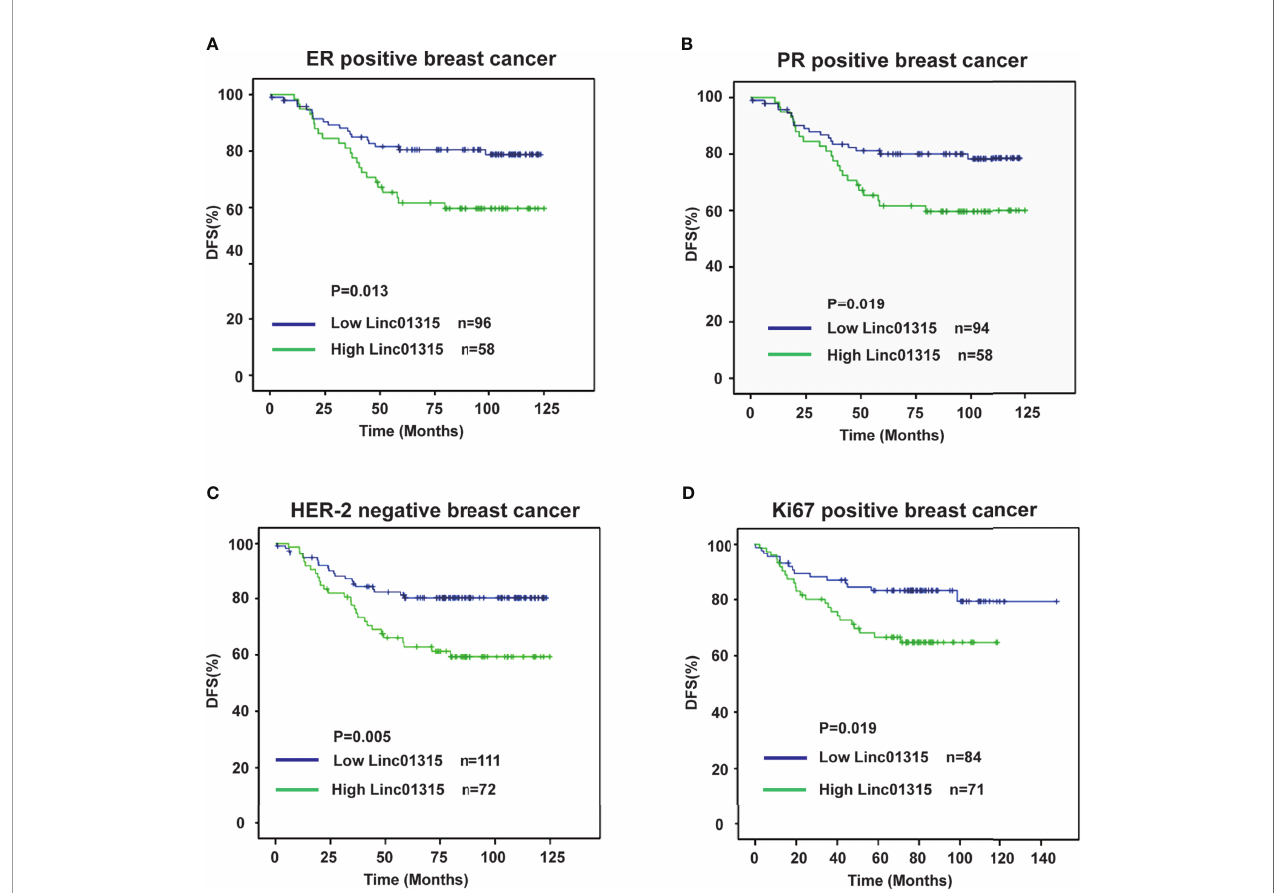
FIGURE 3 | Disease-free survival curves according to breast cancer patients ’ clinic pathological features and Linc01315 expression level. (A) DFS curve of ER positive patients based on the level of Linc01315. (B) DFS curve of PR positive patients based on the level of Linc01315. (C) DFS curve of Her-2 negative patients based on the level of Linc01315. (D) DFS curve of Ki67 positive patients based on the level of